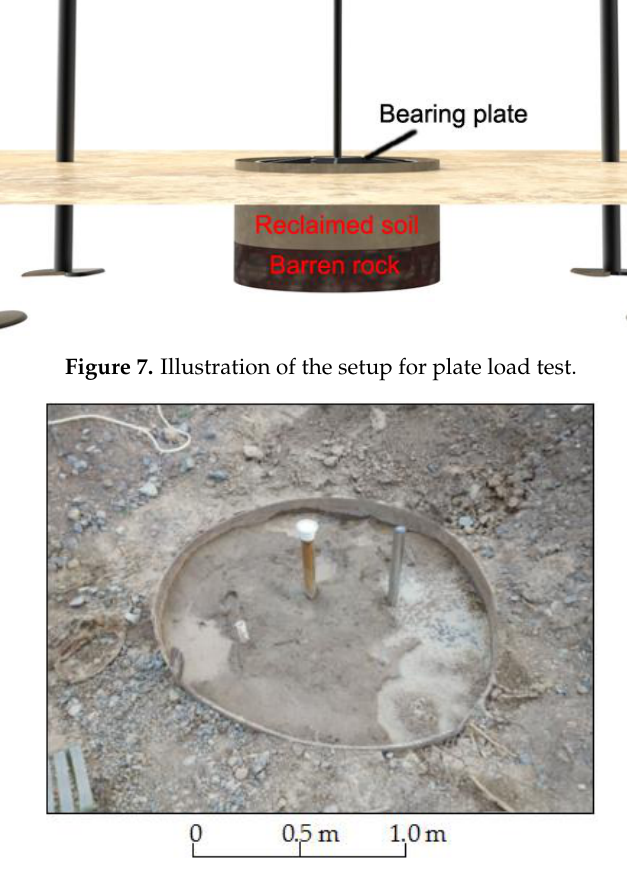
Figure 8. Uncompacted reclaimed soil test barrel after irrigation.